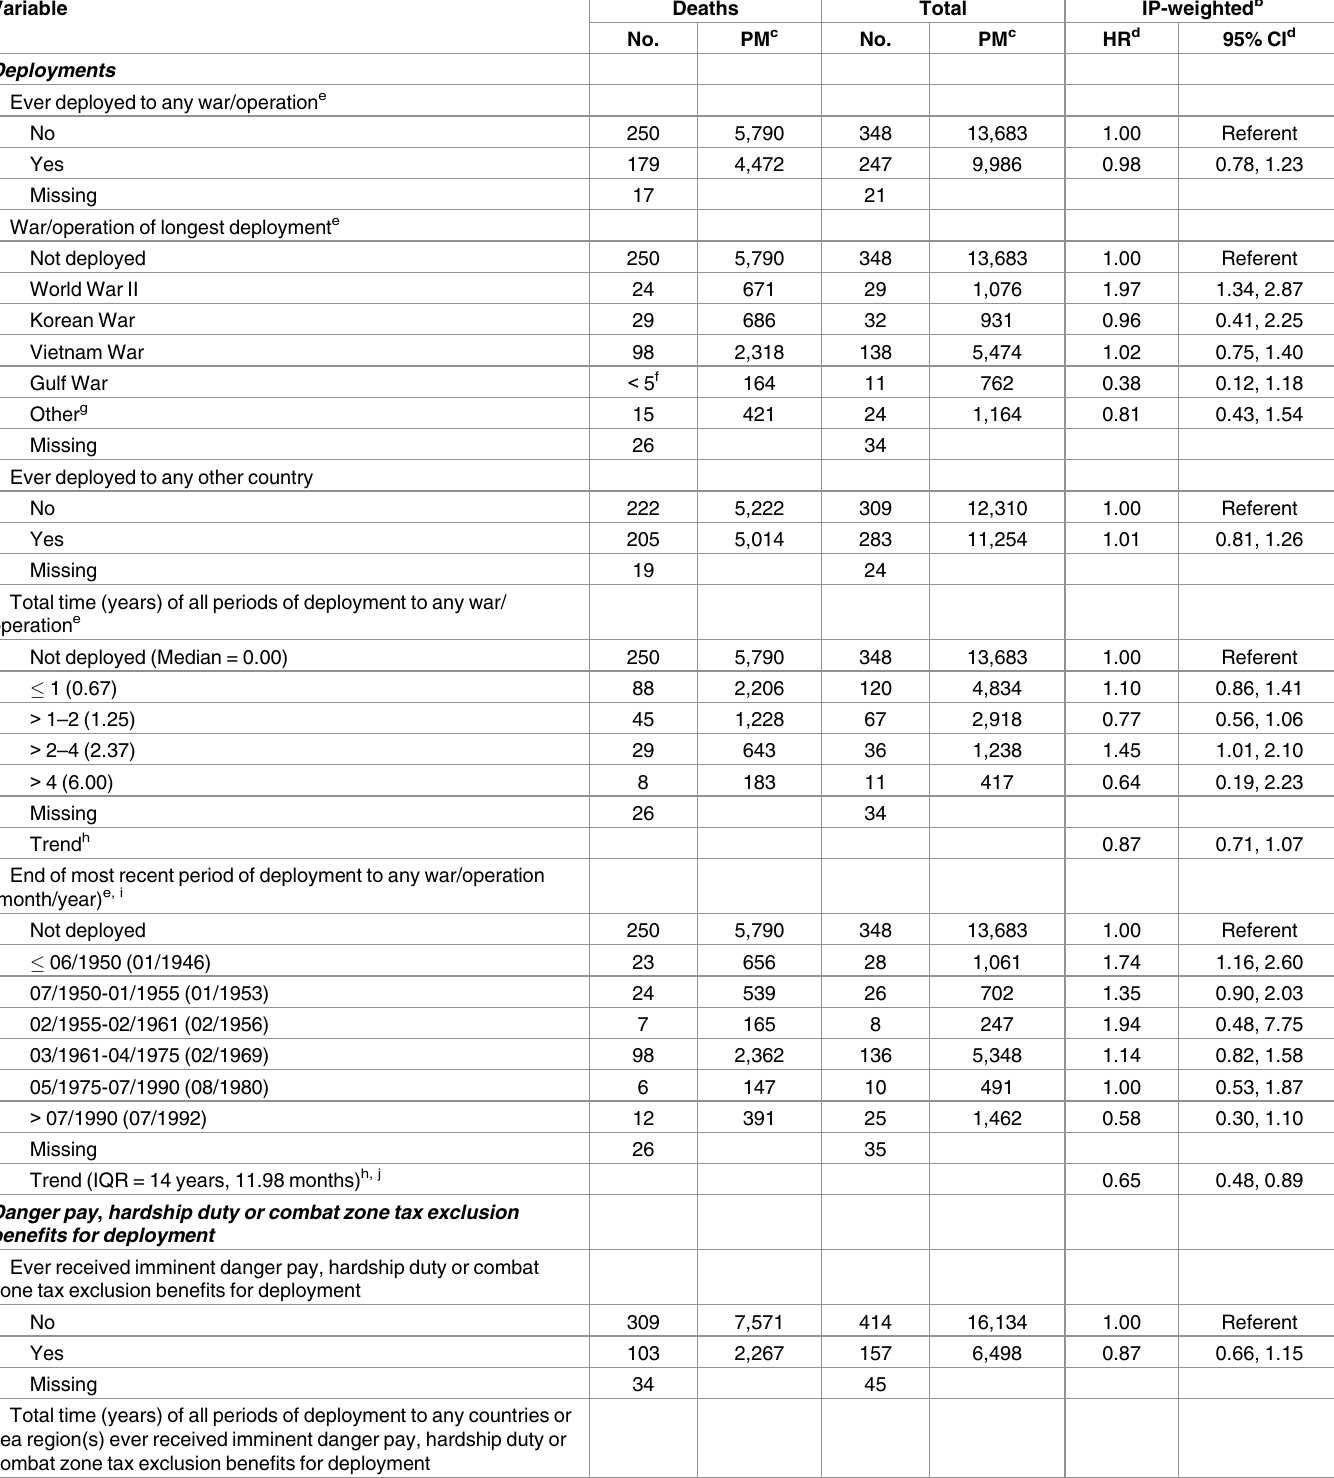
Table 4. Military deployments or danger pay and amyotrophic lateral sclerosis survival in GENEVA a , United States of America, 2005–2013.